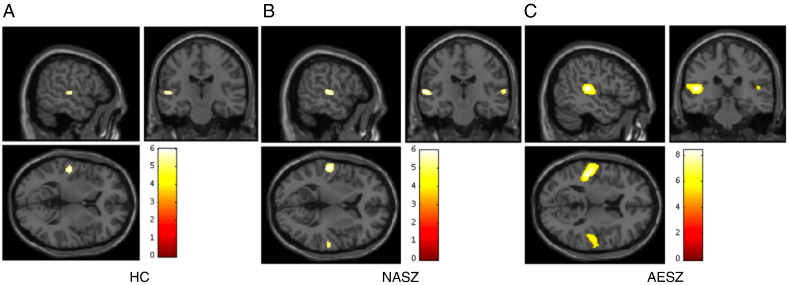
Results of BOLD signals activated by 80-Hz click stimuli compared with resting states. (A) Healthy controls (HC), (peak: left transverse temporal gyrus, [− 54, − 20, 4], t = 6.00, p < 0.001). (B) Non-acute phase schizophrenia patients (NASZ), (peak: left transverse temporal gyrus/planum temporale, [− 56, − 20, 6], t = 5.98, p < 0.001) (peak: right superior temporal gyrus, [64, − 22, 8], t = 5.18, p < 0.001). (C) Acute episode schizophrenia patients (AESZ) (peak: left transverse temporal gyrus/planum temporale, [− 48, − 28, 12], t = 8.43, p < 0.001) (peak: right planum temporale, [54, − 20, 8], t = 6.28, p < 0.001). Colored bars represent the t-value of the contrast (FWE corrected, p < 0.05). The [x, y, z] locations are listed in Montreal Neurological Institute coordinates.